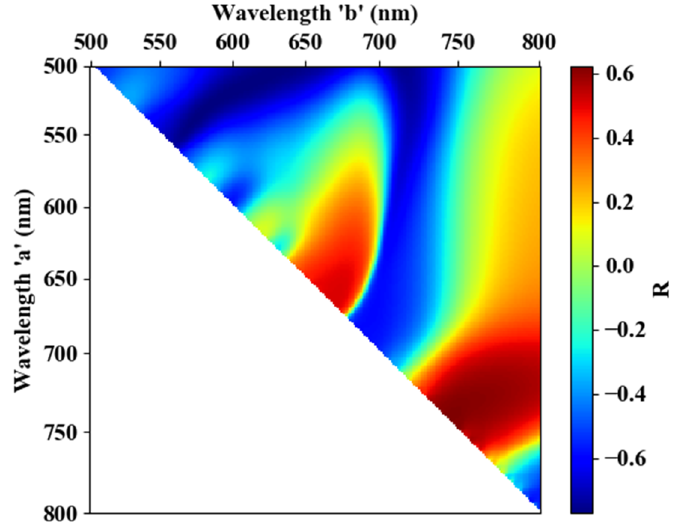
Figure 5. Correlogram between rate of change in reflectance between wavelengths ‘a’ and ‘b’ (RCRW a-b ) and soil–plant analysis development (SPAD) value.